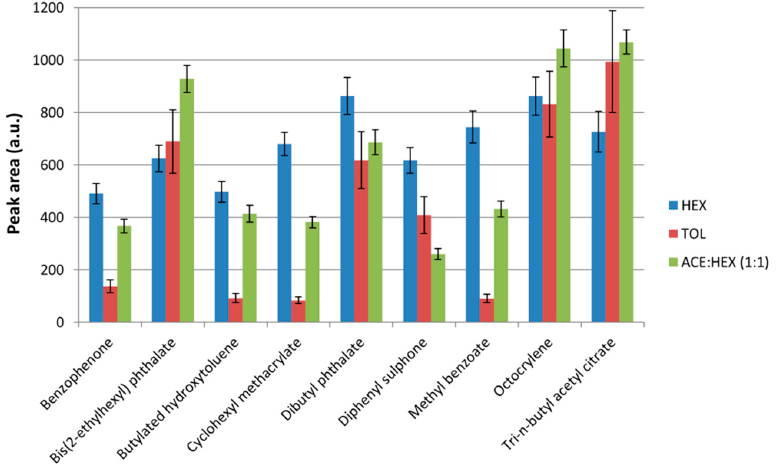
Figure 2. Study of the extraction solvent composition. Experimental conditions: extraction solvent volume, 5 mL; ionic strength, 5% w / v of NaCl; extraction time, 60 s. Bars in the graph represent the mean value of three replicates ± standard deviation. HEX: n ‐ hexane; TOL: toluene; ACE:HEX: mixture of acetone/n ‐ hexane